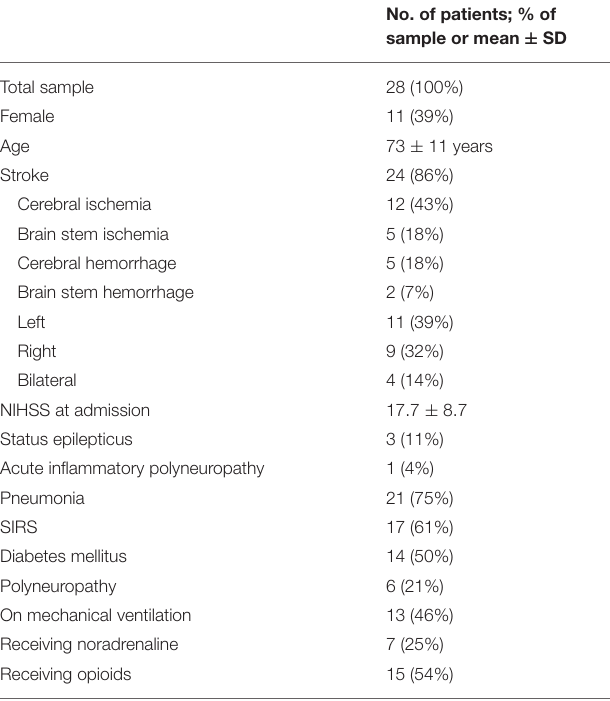
TABLE 1 | Demographic characteristics and clinical parameters at the time of